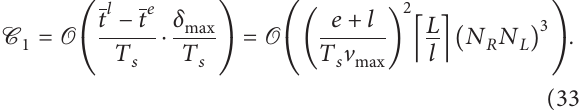
Figure 11: Block diagram of the procedures, and their respective interconnections, associated with the determination of the arrival time t for vehicle A i based on the entry time t i